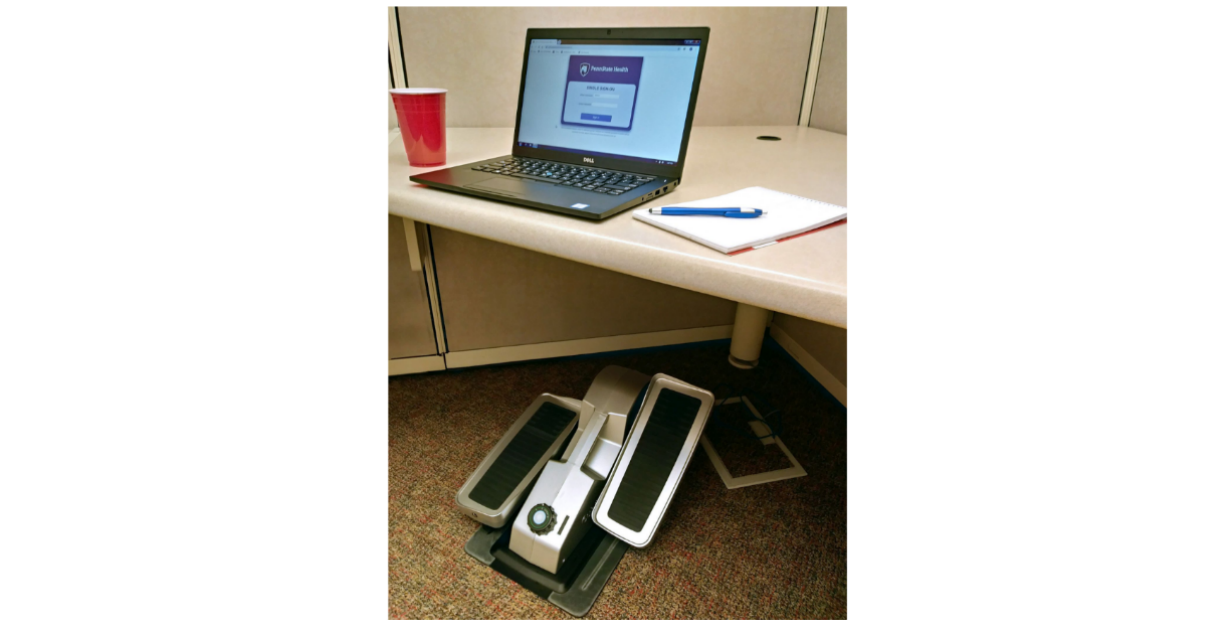
Figure 1. Desk elliptical setup in standard office